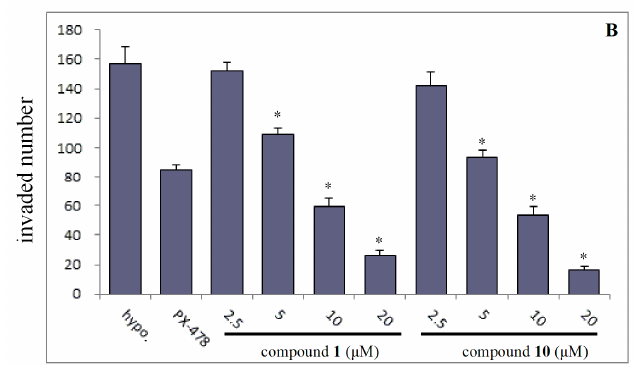
Figure 3. Effects of compounds 1 and 10 under the lower concentration gradient with positive control (PX-478) on invasion of SMMC7721 cell under hypoxia conditions by transwell assays. 1.5 × 10 5 cells were seeded into the matrigel coated (matrigel:DMEM = 1:8) transwell invasion chamber and exposed to compounds for 36 h. ( A ) The invaded cells at the lower side of the membrane were then stained using Crystal Violet. ( B ) The quantification analysis. Column: mean; bar: standard deviation; n = 3. * p < 0.05 compared with the control.